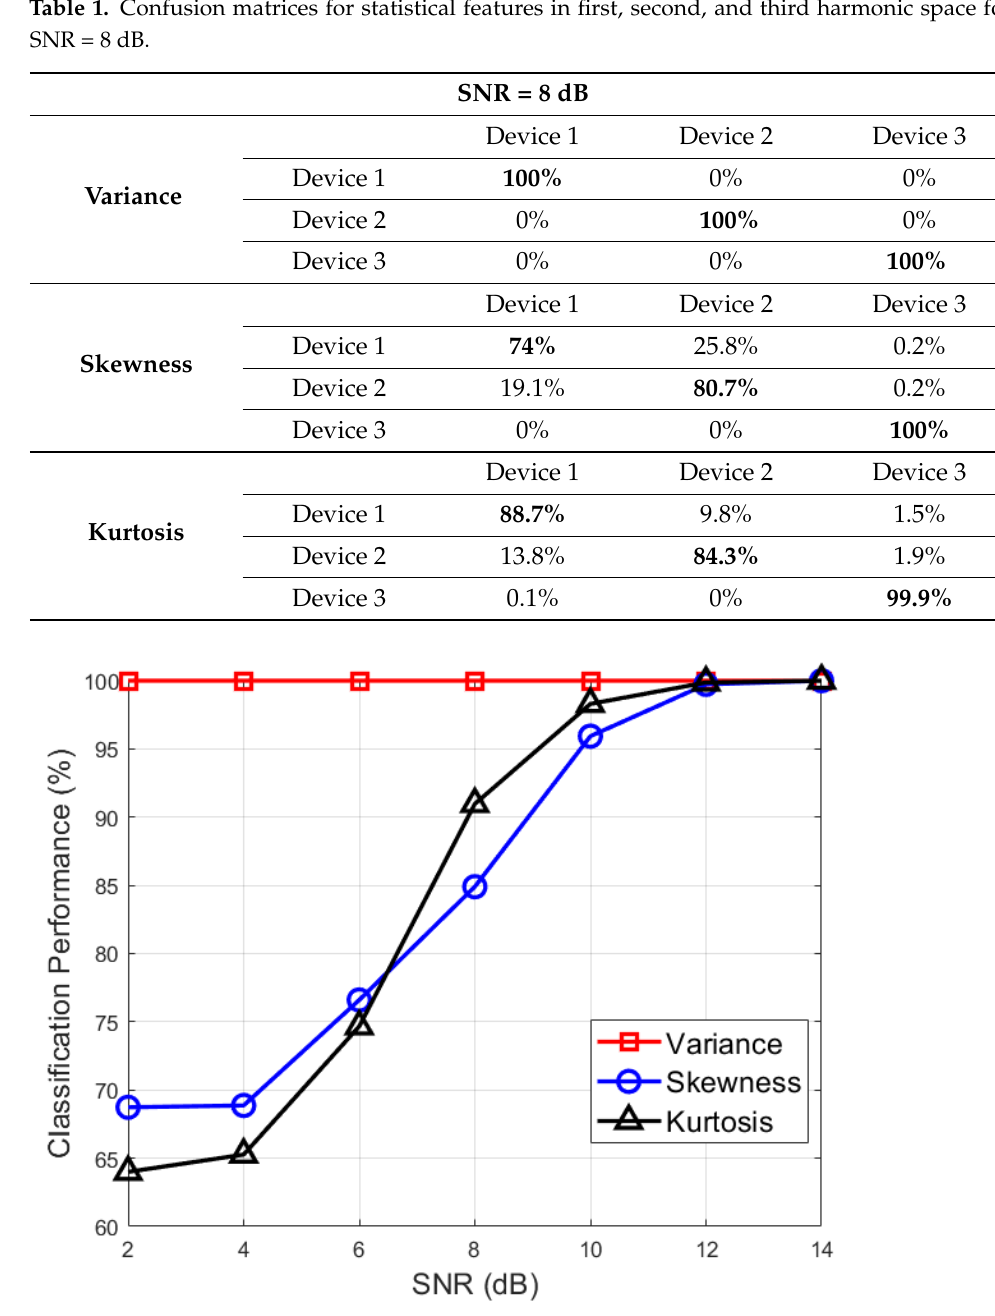
Figure 8. Classification performance of the statistical features for varying SNR values.